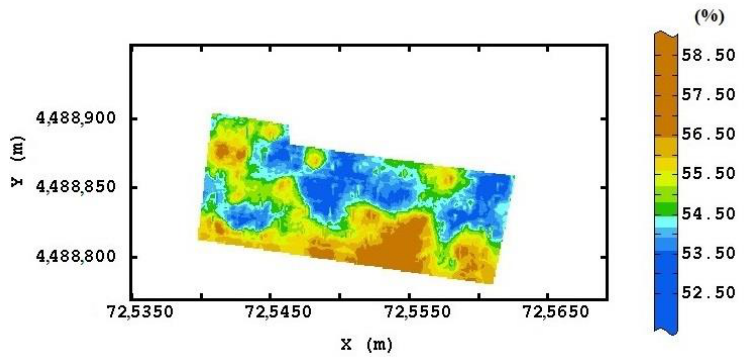
Figure 9. The sand map. Colour scale uses isofrequency classes.